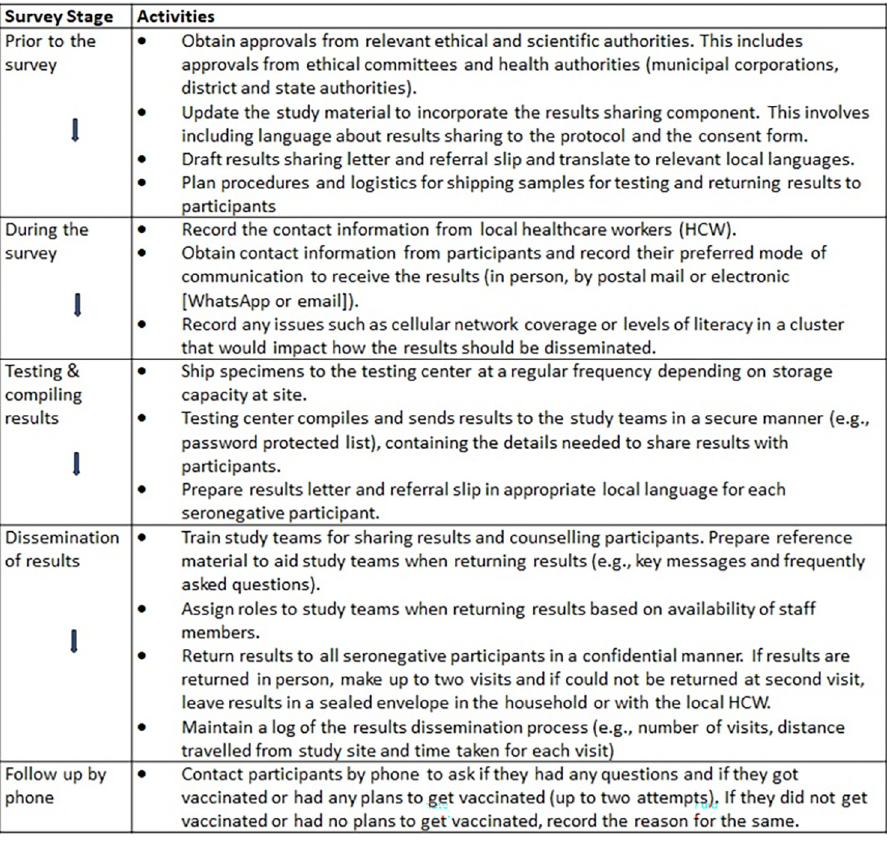
Fig 1. Overview of survey stage and activities involved in returning results to